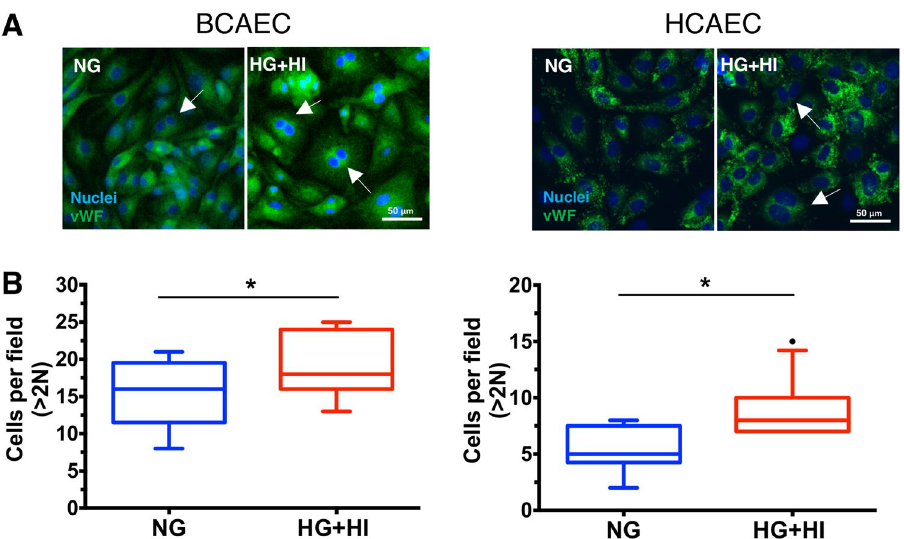
Figure 7. Increased cellular binucleation by simulated diabetes in bovine coronary artery endothelial cells (BCAEC) and human coronary artery endothelial cells (HCAEC). ( A ) Representative immunofluorescence micrographs showing the localization of the von-Willebrand factor (vWf, 1:400, 3% BSA in PBS) in fixed and permeabilized cells. The nuclei were stained using the dye Hoechst 33258 (2 µg/mL in HBSS). White arrows indicate binucleated cells. ( B ) Quantification of binucleated cells in HCAEC and BCAEC under simulated diabetes (HG + HI) versus control (NG) group. Fluorescence images were taken in at least three random fields